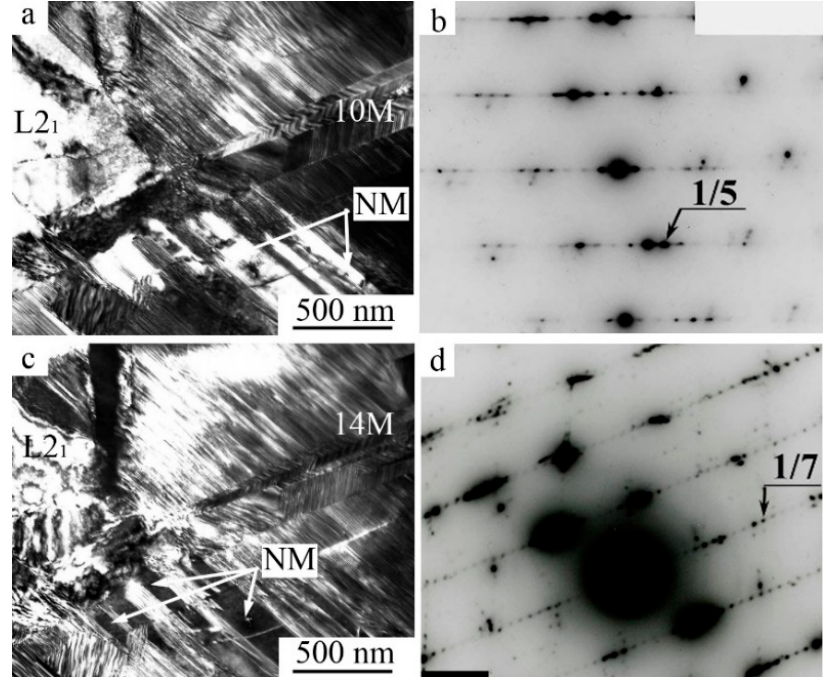
Figure 12. TEM images of the microstructure of the alloy Ni 54 Mn 21 Ga 25 and related SAED ( a , b ) long-period 10 M martensite at room temperature and ( c , d ) long-period 14 M martensite at 130 K.